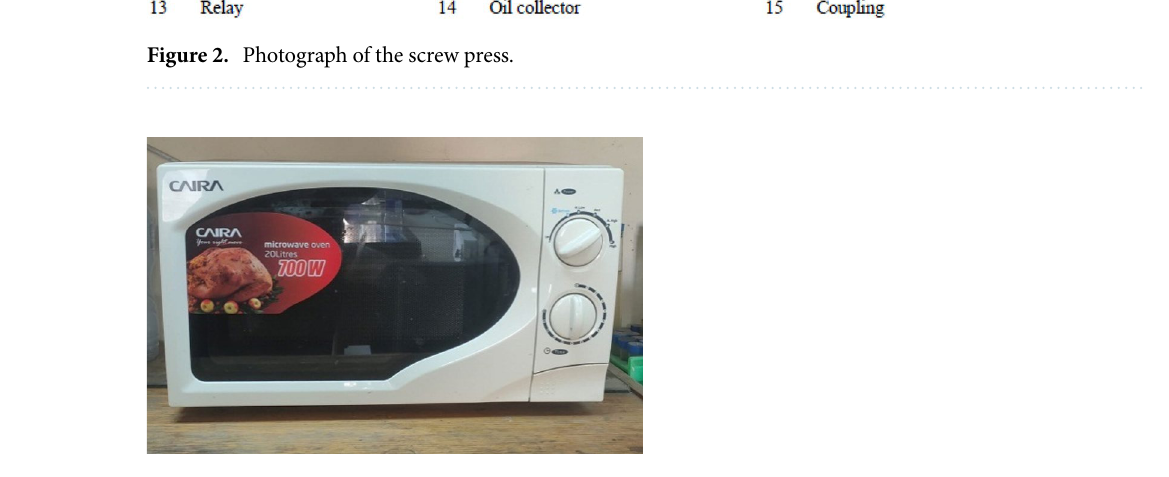
Figure 3. Microwave